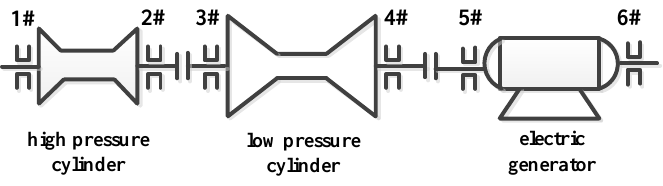
Figure 4. The structure diagram of the 50 MW turbo generator unit.